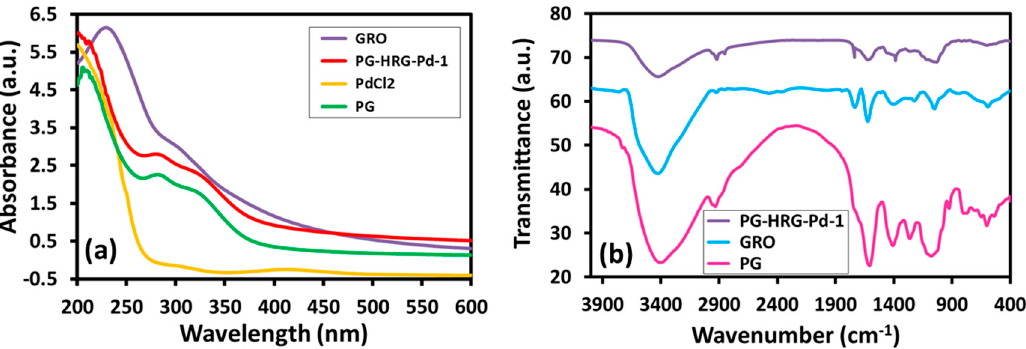
Figure 5. ( a ) UV ‐ Vis absorption spectra of graphene oxide (GRO), Pd@graphene nanocatalyst (PG ‐ HRG ‐ Pd ‐ 1), palladium chloride (PdCl 2 ), and PGE; ( b ) FT ‐ IR spectra of graphene oxide